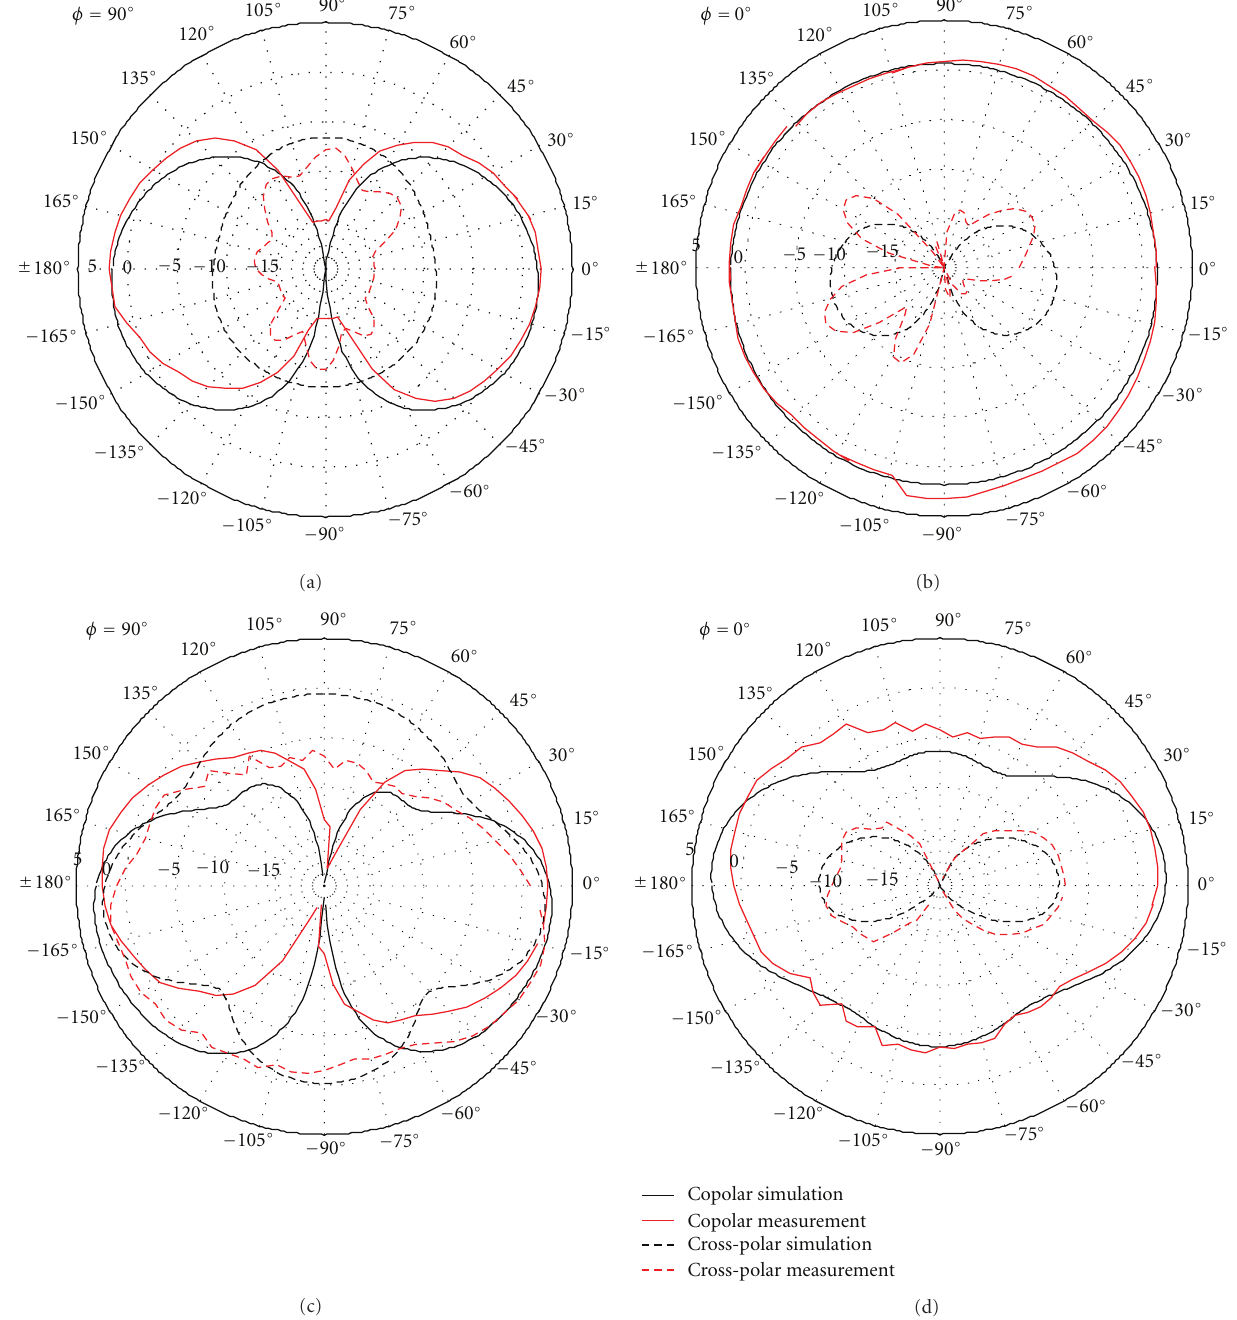
Figure 9: Simulated and measured radiation patterns for port 1 (dB): (a) in the E plane ( YZ plane) at 778 MHz, (b) in the H plane ( XZ plane) at the 778 MHz, (c) in the E plane ( YZ plane) at 2.6GHz, and (d) in the H plane ( XZ plane) at 2.6 GHz.